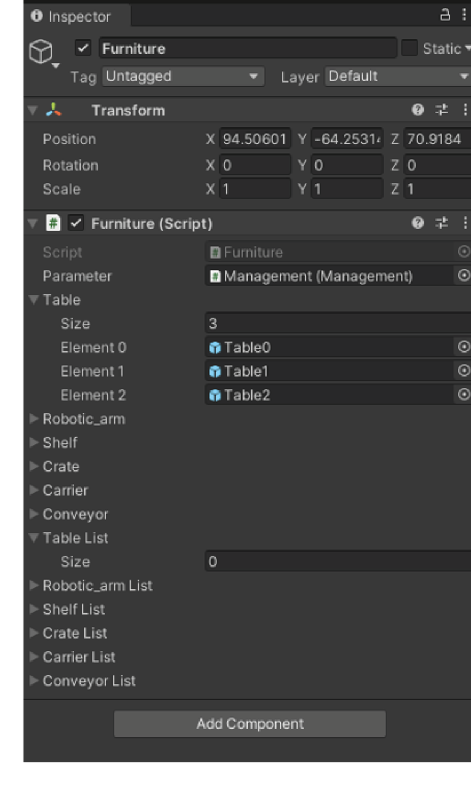
Figure 8: therein, on the left, the 3D models of a robot arm and a mobile manipulator are shown, together with the corresponding hierarchy.